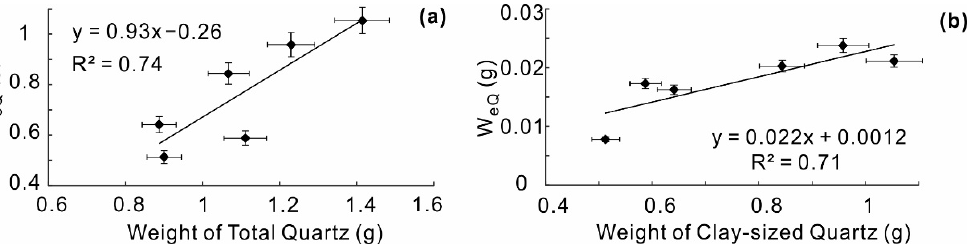
Figure 12. Cross-plots of weight of clay-sized quartz (W cQ ) versus ( a ) weight of total quartz in bulk shale (W tQ ), ( b ) weight of “elongated” quartz (W eQ ). Note: weight in 1 cm 3 shale. Error bars show a 5 % variation in each data point.